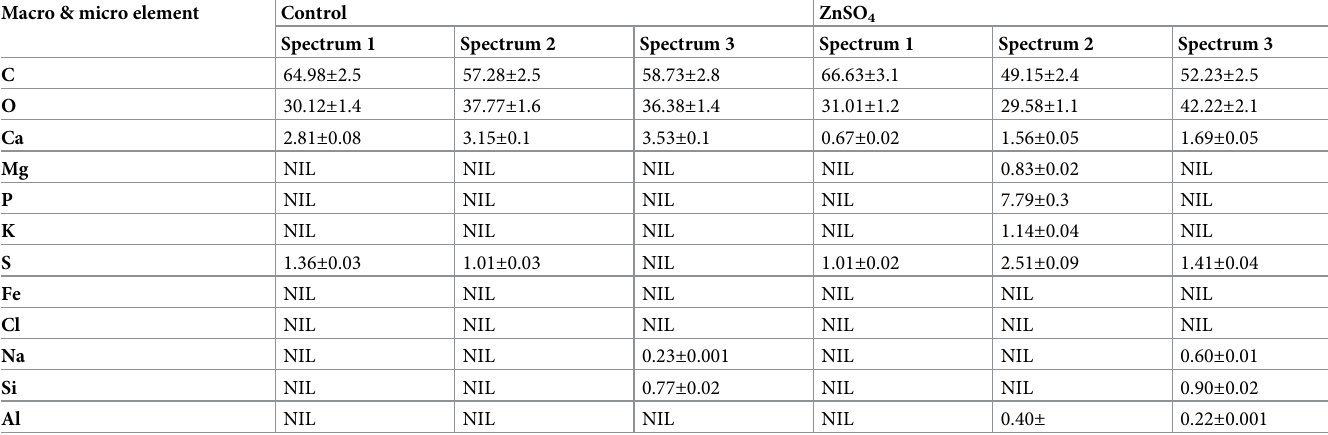
Table 2. FEG-SEM EDX microanalysis data in the roots of Acanthus ilicifolius L. cultured in Hoagland solution. The macro and microelements concentrations (% weight) are shown for 3 different spots, i.e., spectrum 1 (outer region), spectrum 2 (middle region) and spectrum 3 (inner region). Macro & micro